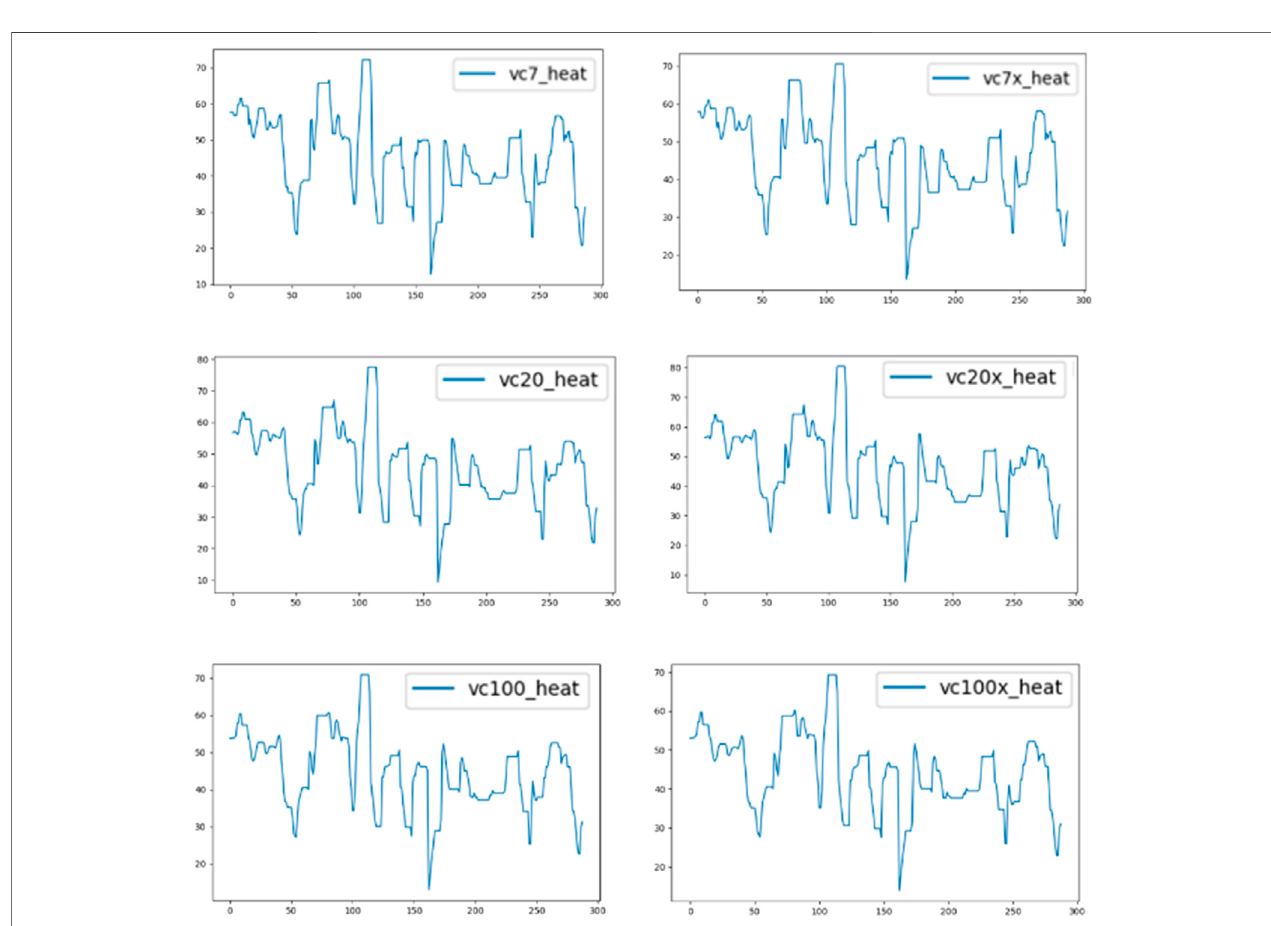
FIGURE 8 | August 3, 2021 six trading popularity indices.